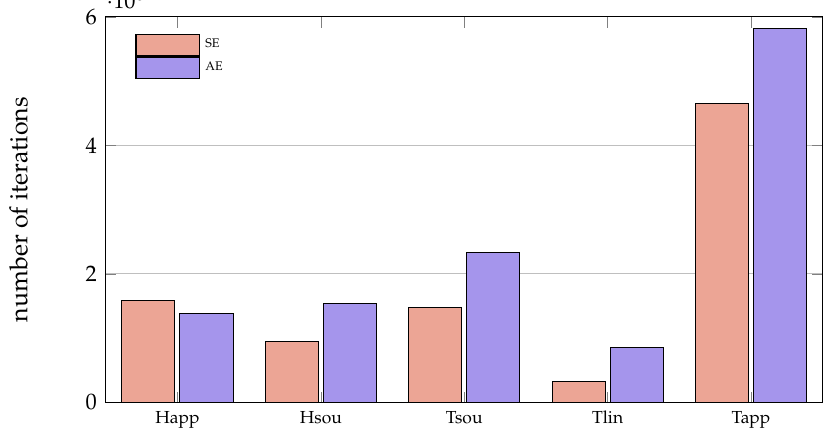
Figure 3. Mean values of the number of iterations for each solver.